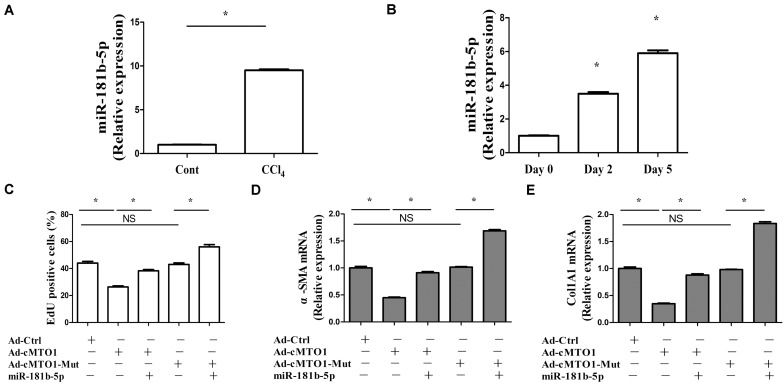
miR-181b-5p takes a part in the effects of cMTO1 on HSC activation. Primary 1-day-old HSCs were transduced with Ad-cMTO1 or Ad-cMTO1-Mut for 48 h and transfected with miR-181b-5p mimics for additional 48 h. (A) miR-181b-5p level in CCl4 mice. (B) miR-181b-5p level in primary HSCs. (C) Reduced cell proliferation by cMTO1 over-expression was restored by miR-181b-5p. (D,E) cMTO1-suppressed α-SMA and Col1A1 were blocked down by miR-181b-5p. *P < 0.05 compared to the control. Each value is the mean ± SD of three experiments.